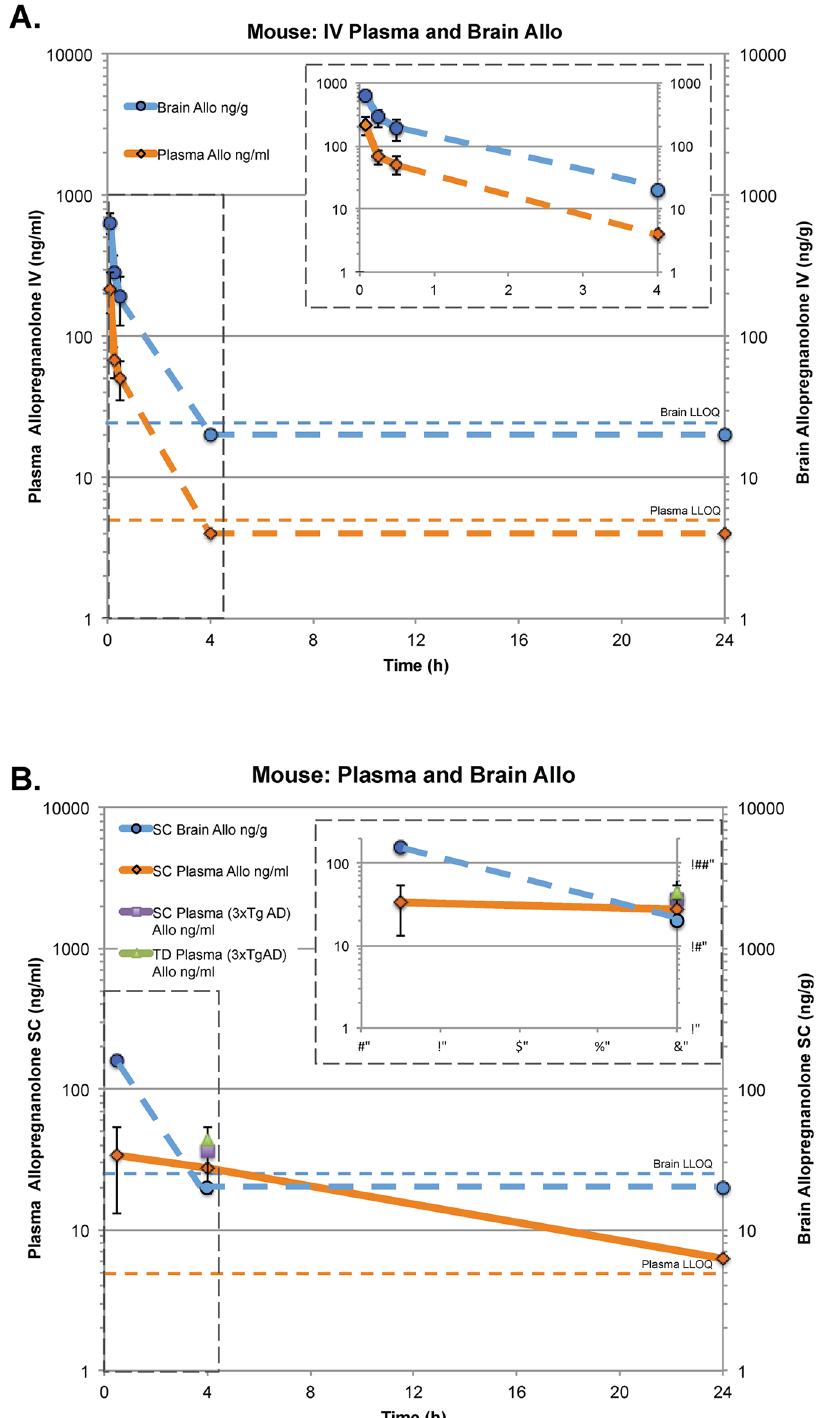
Fig 2. Mouse plasma and brain concentration-time profiles of allopregnanolone following intravenous (IV), subcutaneous (SC) and transdermal (TD) administration. A. Dosing at 1.5 mg/kg IV using Allo solution in 6% HBCD vehicle in male non-transgenic mice (15-months-old, n = 5 – 6). B. Dosing at 10 mg/kg SC using Allo suspension in 5% EtOH/PBS vehicle in male non-transgenic mice (15-months-old, n = 1 – 3), at 10 mg/kg SC using Allo suspension in 5% EtOH/PBS vehicle in male 3xTgAD mice (5-months-old, n = 6) and 50 mg/kg TD using Allo solution 45% DMSO, 30% EtOH, 2.5% Klucel MF, 19.2% PEG-300 (5-months-old, n = 8). Data points represented as mean ± SD. LLOQ: Lower Limit of